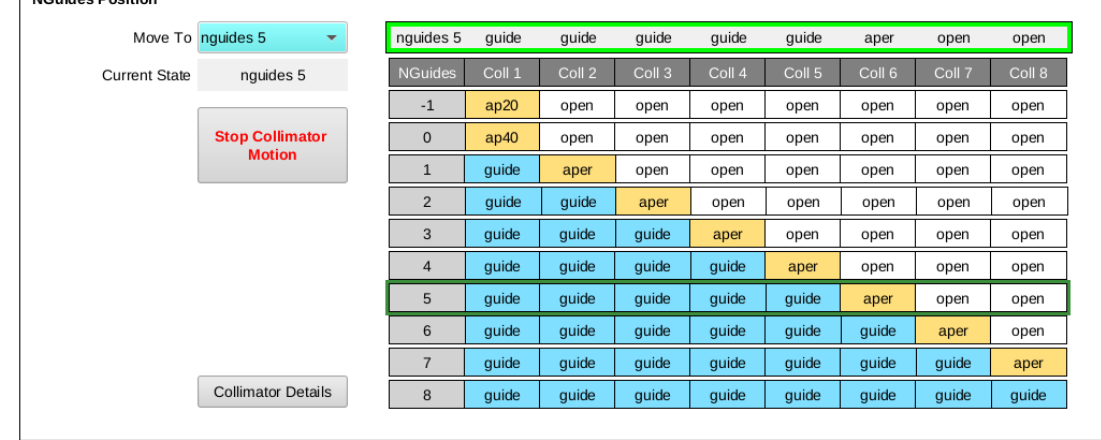
Figure 4. An example of motor grouping, the pseudo-motors for guide operation in the collimation system.